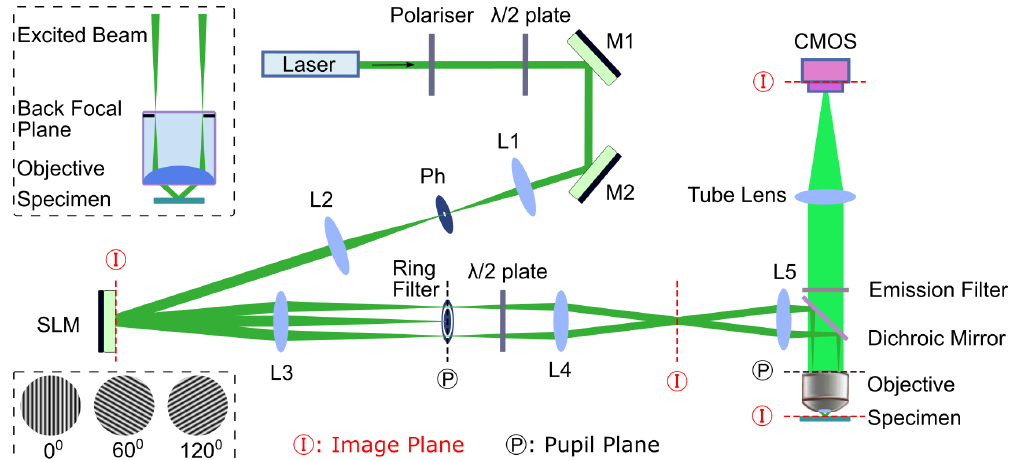
Fig. 3. Schematic setup of a 2D structure illumination microscope by two beam interference.